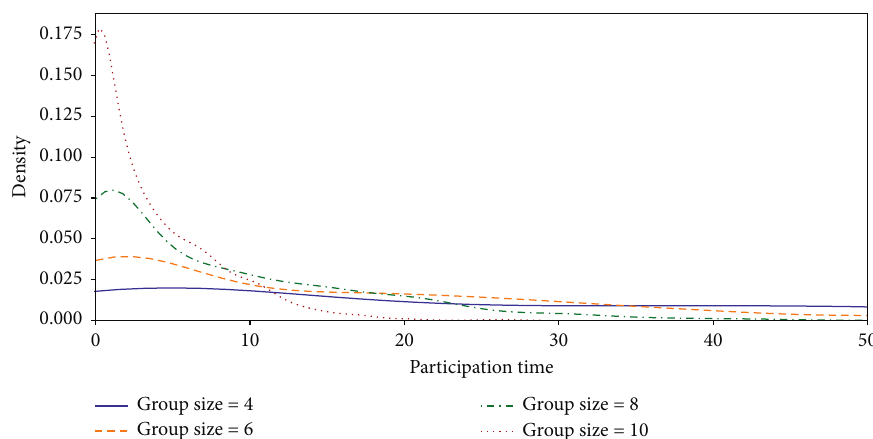
Figure 8: Distribution of participation times in different sized groups. The data was collected from 100 independent simulation runs (300 iterations). The ideal maximal participation time is 300, yet for a better visualization, here we only show the data within 50 participation times.